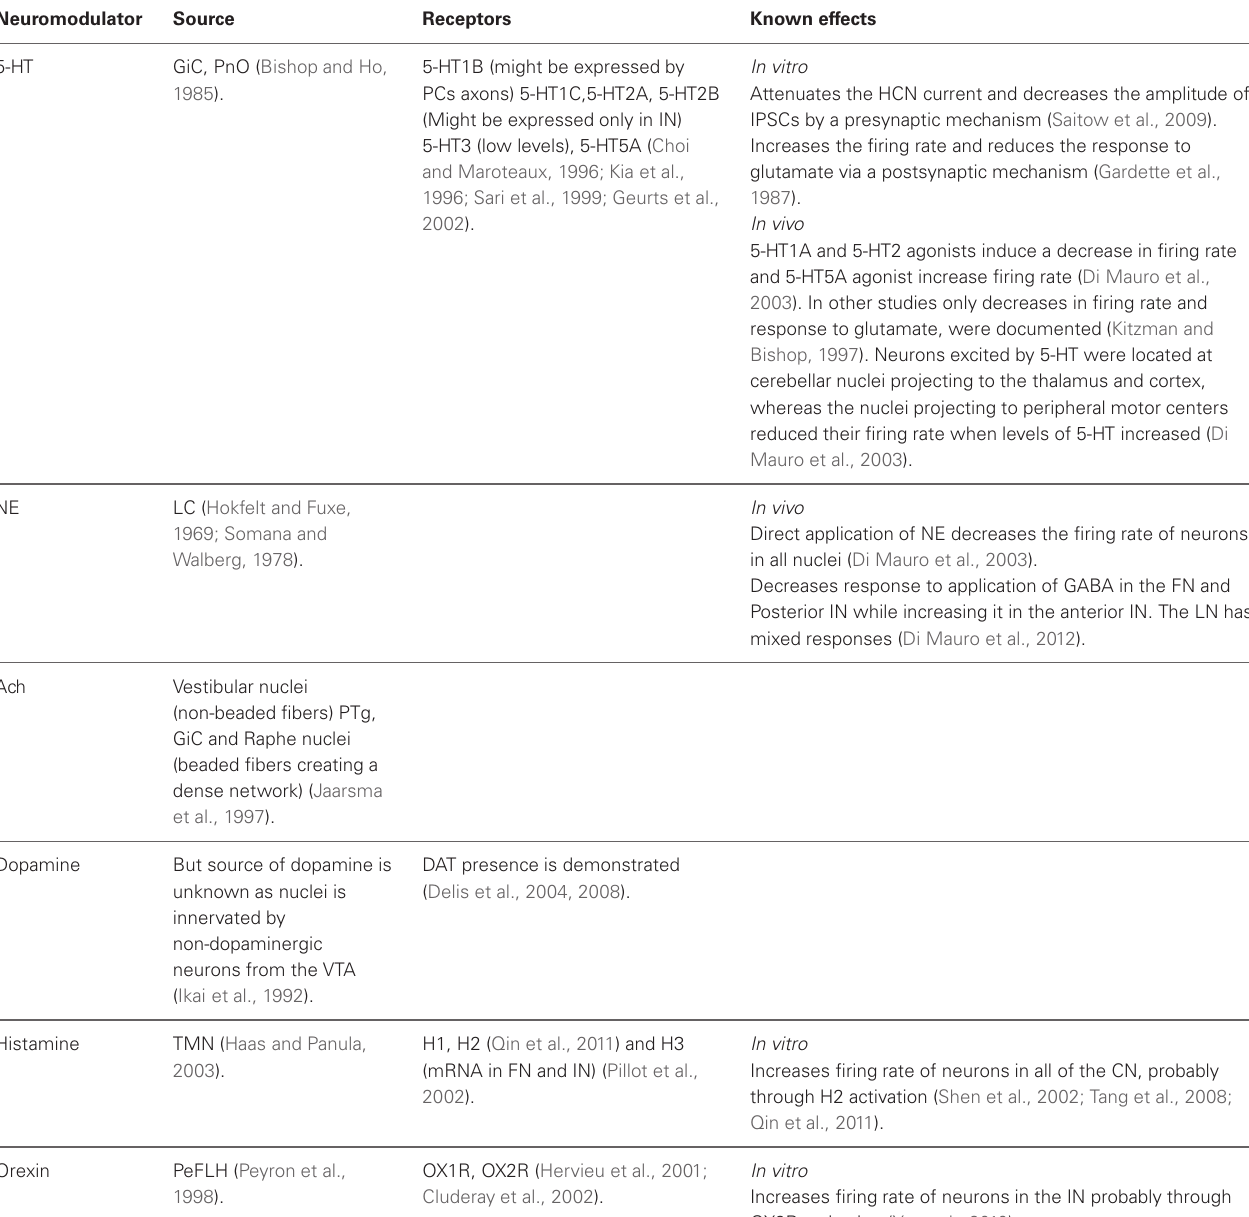
Table 1 | Neuromodulators of CN.